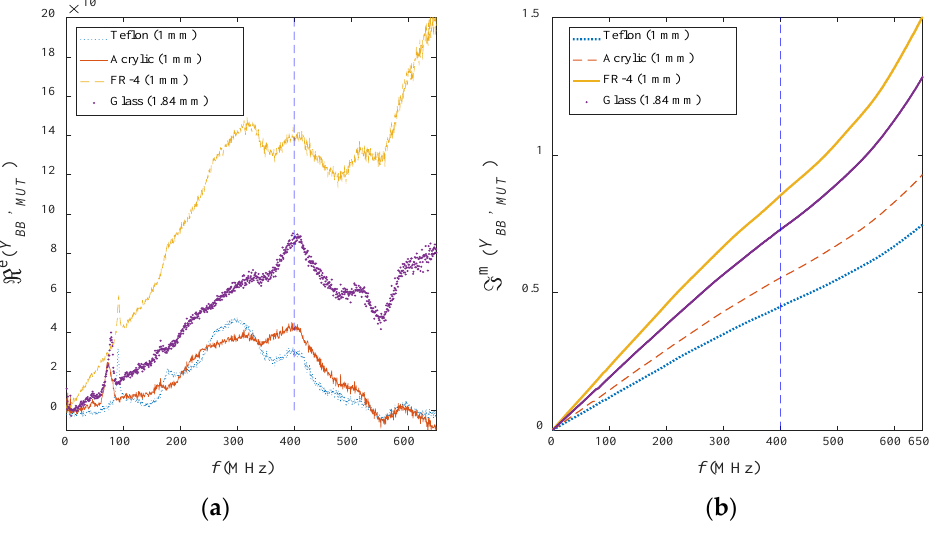
(cid:16) (cid:17) (cid:16) (cid:17) , and ( b ) imaginary part, J m , of the (cid:101) Y BB (cid:48) _ MUT (cid:101) Y BB (cid:48) _ MUT